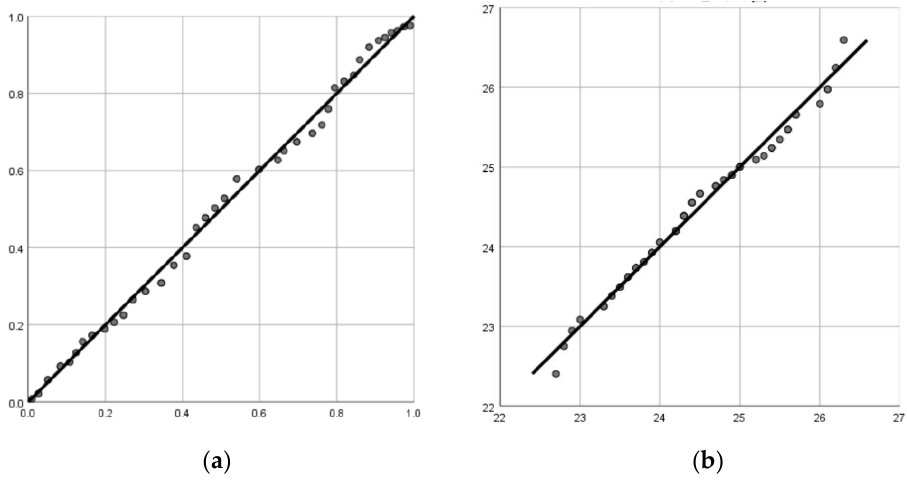
Figure 2. The results of Graphical method in Shandong Zichuan station ( a ) P-P plot, ( b ) Q-Q plot.